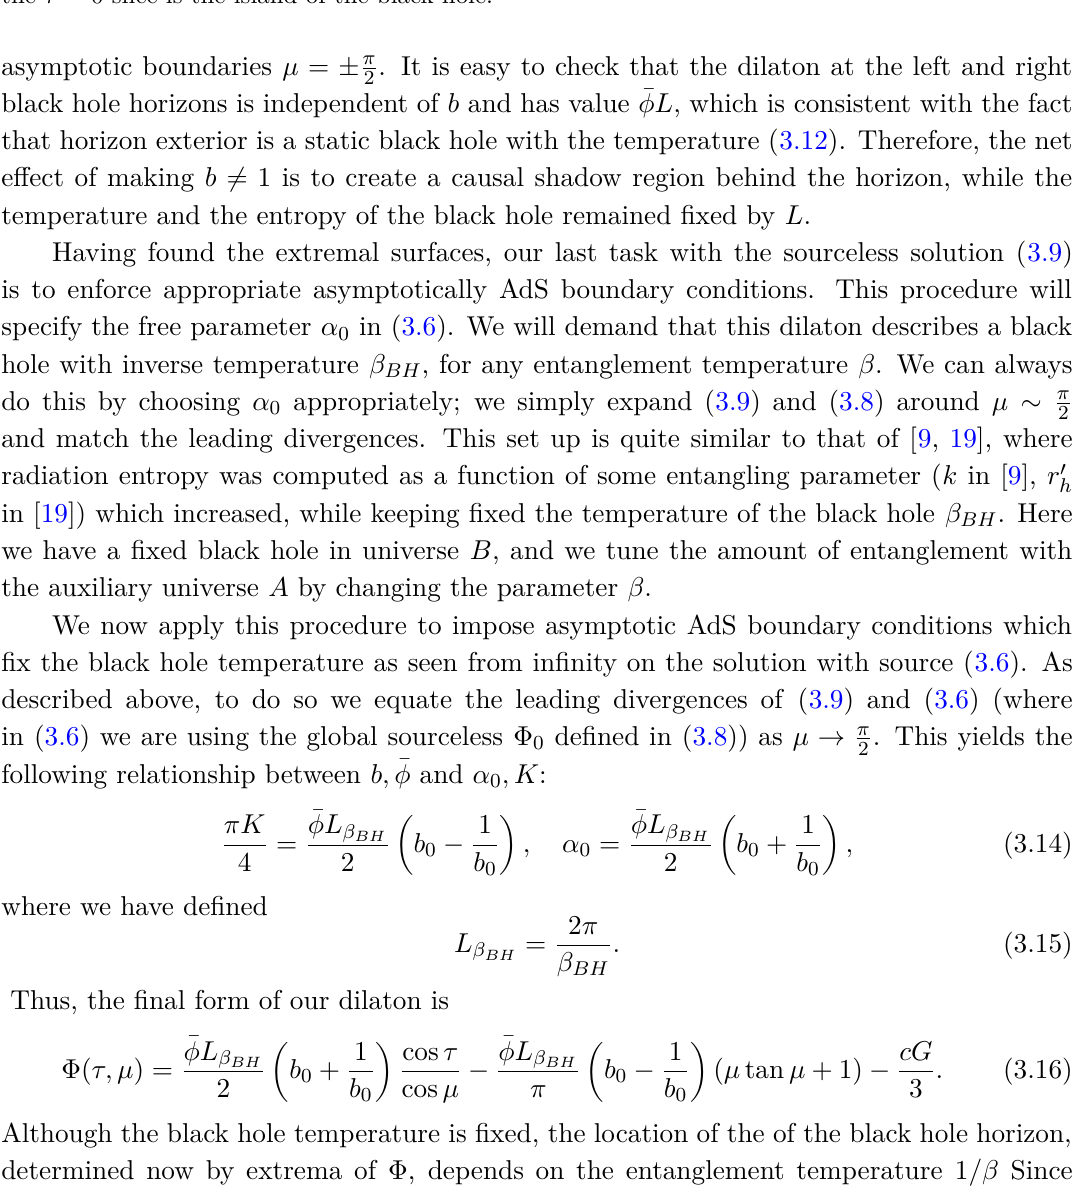
Figure 3 . The Penrose diagram of the backreacted black hole with the dilaton profile (3.16). Near asymptotic boundaries µ → π , it looks like an eternal black hole (3.11) with a fixed temperature 2 1 /β BH . The shaded region is the causal shadow region, which is not causally accessible from both of the asymptotic boundaries. As we increase the entanglement temperature 1 /β , the size of the causal shadow region increases, and the event horizons approach the boundaries. The blue line in the τ = 0 slice is the island of the black